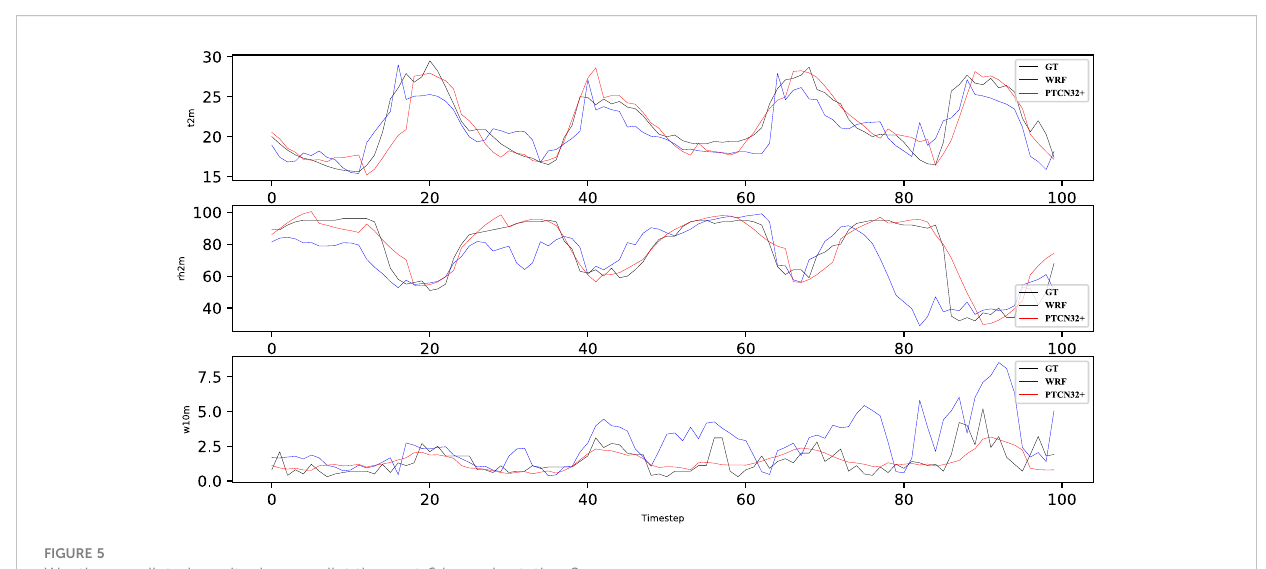
FIGURE 5 Weather predicted result when predict the next 6 hours in station